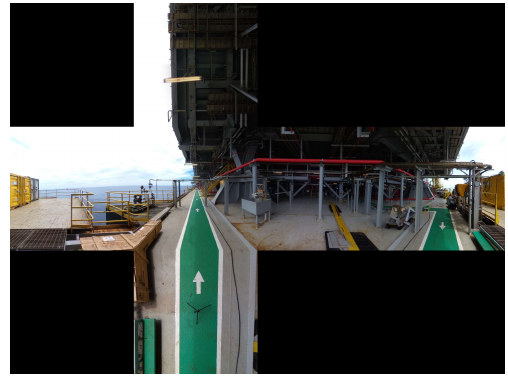
Figure 5. Example of a cubemap